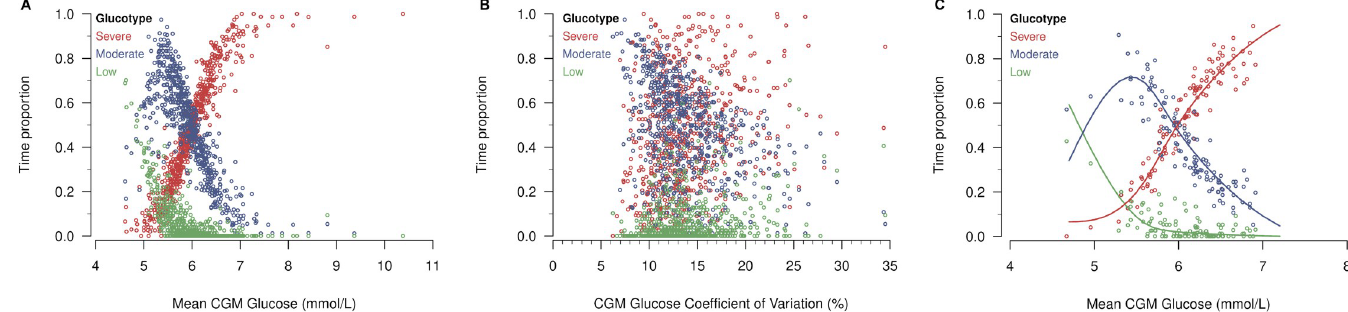
Fig 2. Observed proportion of time spent in the 3 glucotypes by mean CGM glucose (A) and coefficient of variation (B) in The Maastricht Study, and by mean CGM glucose in the PRE-D Trial (C) alongside predicted proportions based on the regression analysis in The Maastricht Study. CGM, continuous glucose monitoring.